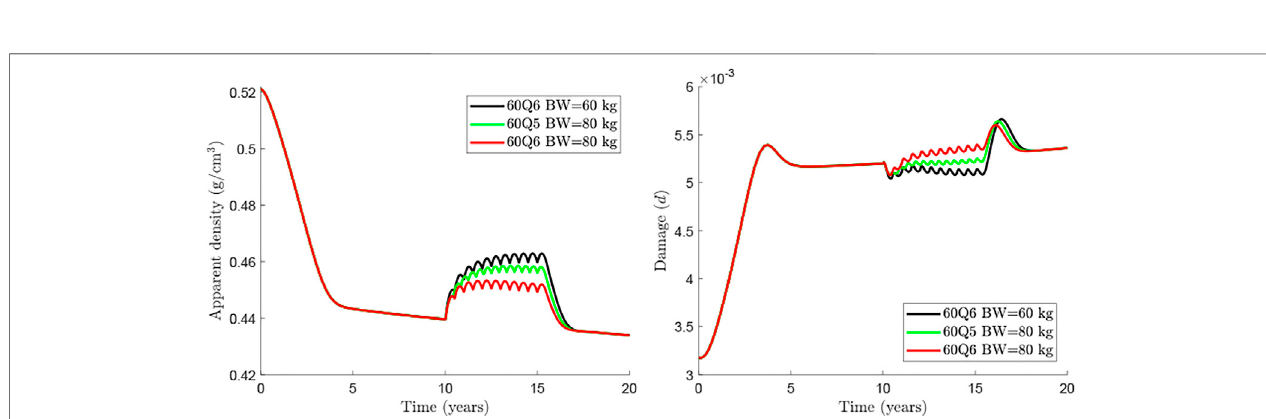
FIGURE 6 | Comparison of treatments 60Q6 and 60Q5 commencing 10 years after menopause and discontinued after 8 years for different body weights.